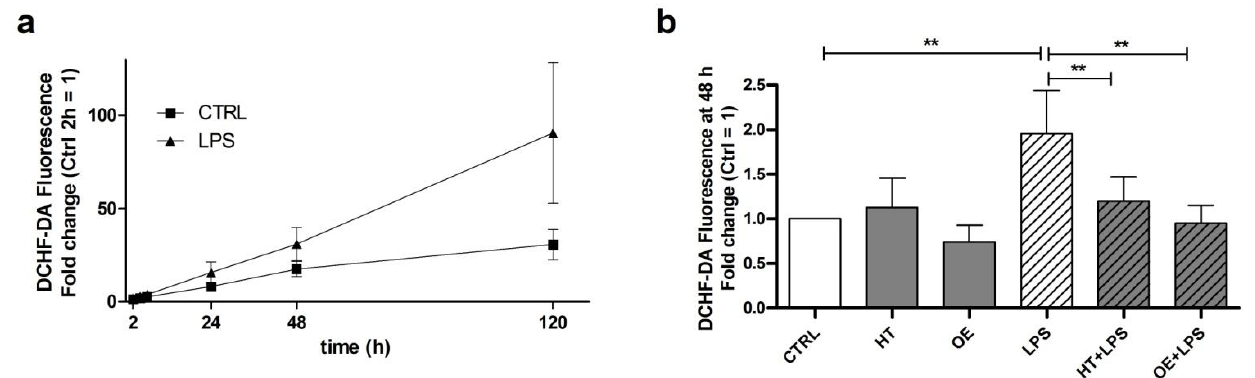
Figure 2. Antioxidant effect of OE and HT in C28/I2 chondrocytes. ( a ) LPS treatment increases ROS production progressively from time 2 h to 120 h compared to control. ROS were assessed by fluorescence intensity of DCHF-DA. ( b ) Pretreatment of C28/I2 chondrocytes with olive-derived nutraceuticals OE and HT showed a statistically significant reduction in LPS-induced oxidative stress at 48 h. Data represent results from multiple analysis ( n = 4) of quadruplicate samples for each experimental condition expressed as mean ± SEM and normalized with respect to the control at 48 h. Statistical analysis was performed by ANOVA, followed by Newman–Keuls’ post hoc test, with ** p < 0.01.